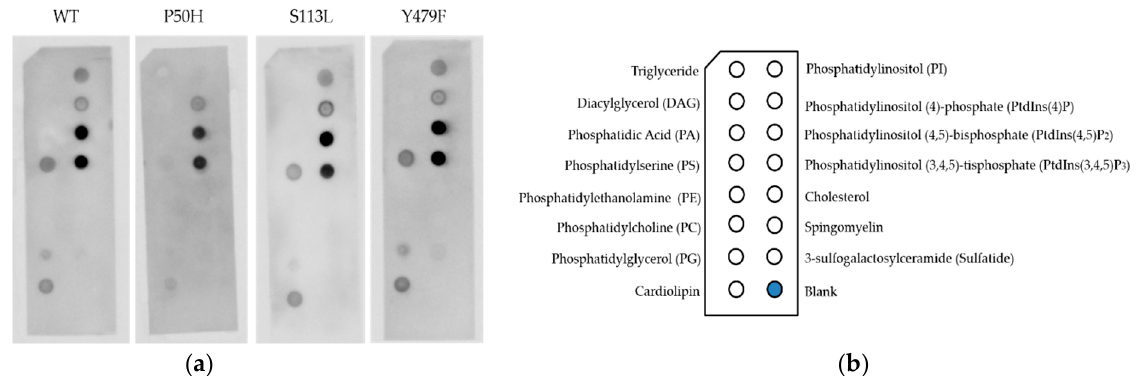
Figure 5. Interaction of recombinant CPT II WT and variants S113L, P50H and Y479F with phospholipids of the mitochon- drial membrane. ( a ) Binding of CPT II WT and variants P50H, S113L and Y479F (final enzyme amount 0.4 mg) to lipids on membrane lipid strips. ( b ) Schematic diagram of immobilized phospholipid species on membrane lipid strips. The experiment was performed at least three times independently.